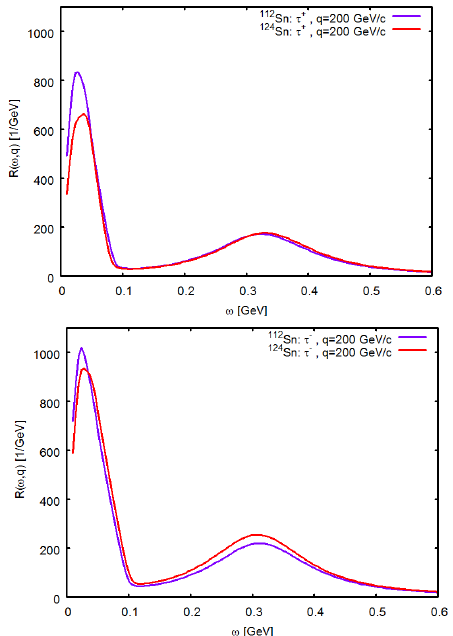
Figure 9. (Color online) Charged current response functions in 112 , 124 Sn as a function of the excitation energy ω and fixed momentum transfer q . The quasi-elastic peak at low excitation energies and the Δ peak at higher energies are clearly